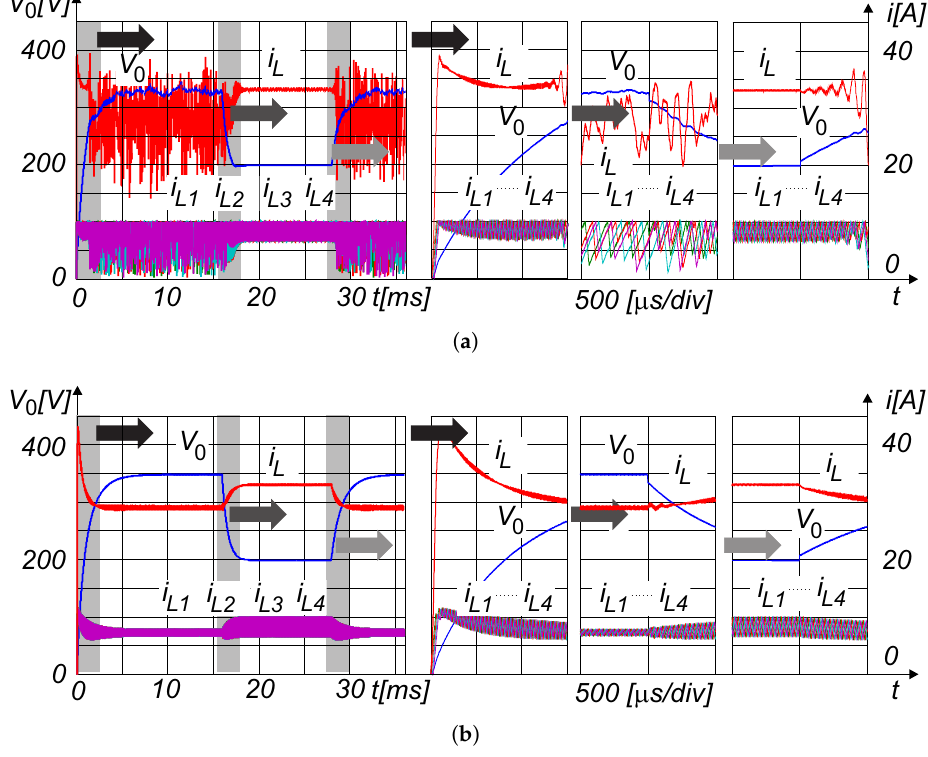
Figure 11. Simulation results, current-programmed mode control, buck-mode: ( a ) without CR; ( b ) with CR; V 0 (blue curve), i L (red curve), i L 1 (green curve), i L 2 (violet curve), i L 3 (cyan curve), and i L 4 (dark red